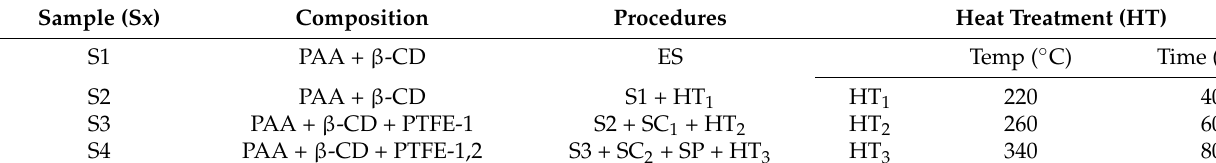
Table 1. Summary of the methods, composition and heat treatments of Sx samples.